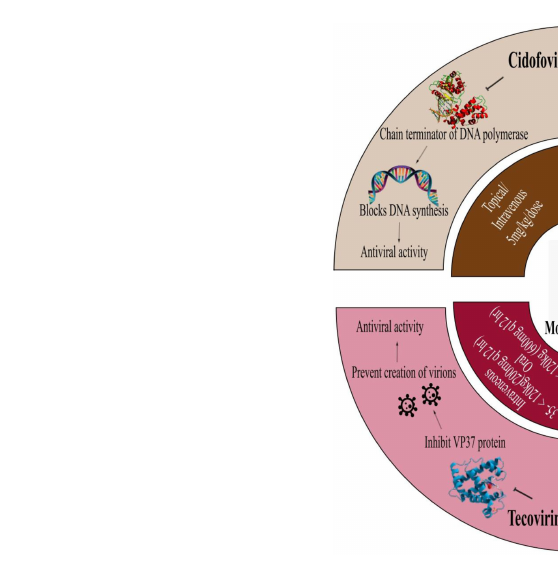
FIGURE 6 Representing mechanism and dose of various monkeypox